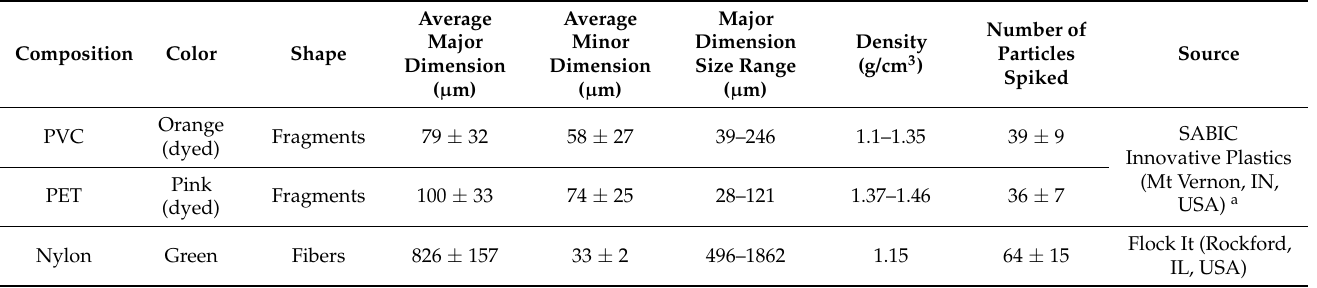
Table 2. Characteristics and concentrations of spiked